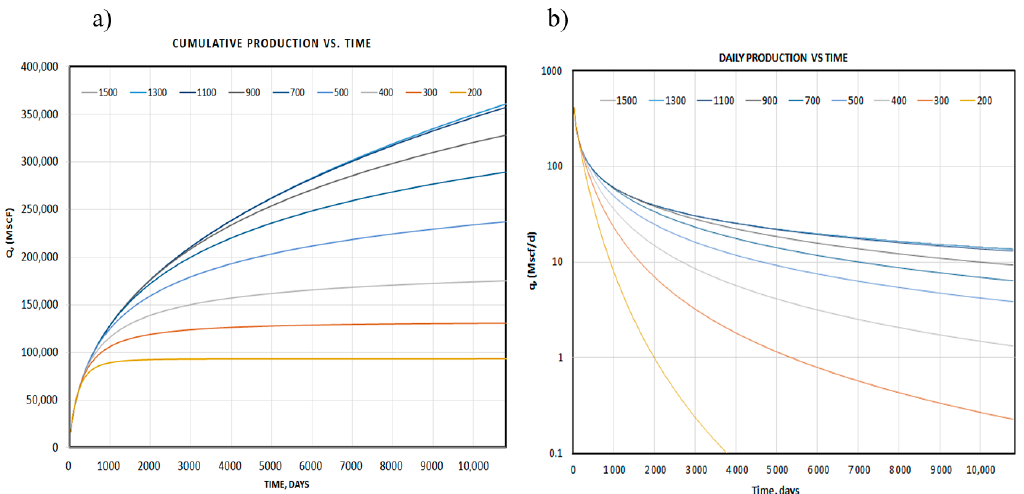
Table 7. Variation of 5-year and 30-year EURs (Mscf) when producing with well spacing varying between 200 and 1500 ft, as forecasted by the flow-cell model.